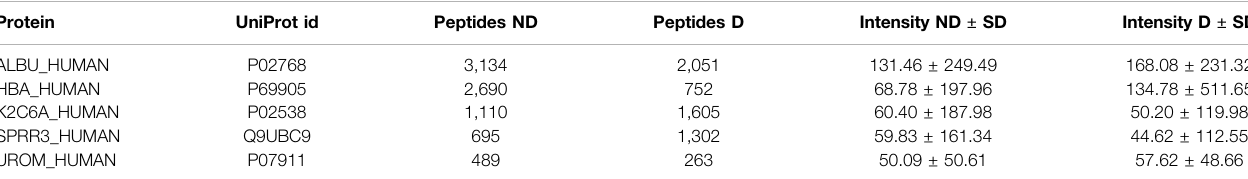
TABLE 3 | Protein table. The table contains the top fi ve most abundant proteins in both groups.